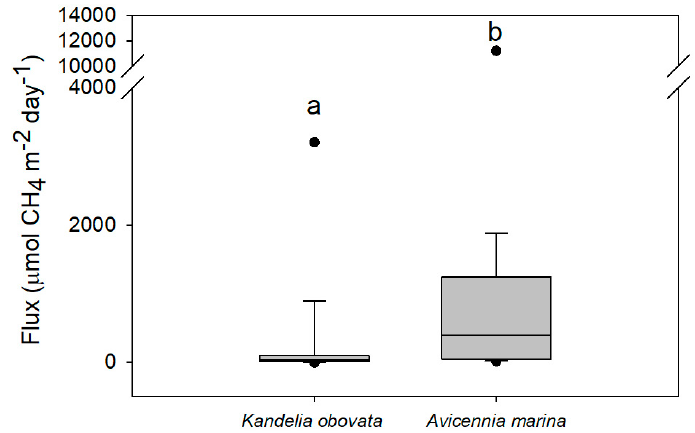
Figure 5. Comparison of methane fluxes between the mangroves of Kandelia obovata and Avicennia marina . Different letters indicate a significant difference ( p = 1.25 × 10 − 5 ) with the Wilcoxon rank-sum test. Table 5. Comparisons of methane fluxes between the mangroves of Kandelia obovata and Avicennia marina with the Wilcoxon rank-sum test (a significant difference at p < 0.05; n.s. = no significance). ORP: redox potential